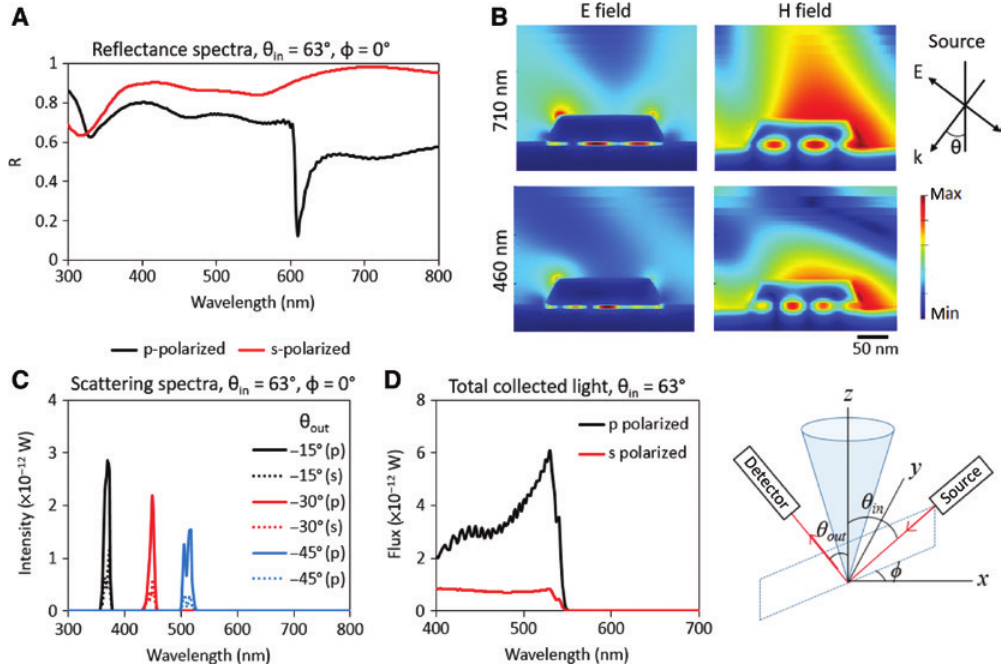
Figure 3: FDTD simulations of arrays of Al disks. (A) Reflectance from a 63 ° -polar angle ( θ ), 0 ° -azimuthal angle ( φ ) plane wave source for an array of 200 nm wide disks with P P of 220 nm. (B) Electric and magnetic fields for p -polarized illumination at 710 nm and 460 nm wavelengths. (C) Scattered field spectra for y a rectangular array of 200 nm wide disks with P of 320 nm and P of 220 nm, under p - and s -polarized illumination from polar angle of 63 ° x y and azimuthal angle of 0 ° . Fields are collected at the same azimuthal angle and polar angles between 0 ° and 45 ° . (D) Total scattered light within a collection cone with half-angle of 53 ° , for p - and s -polarized